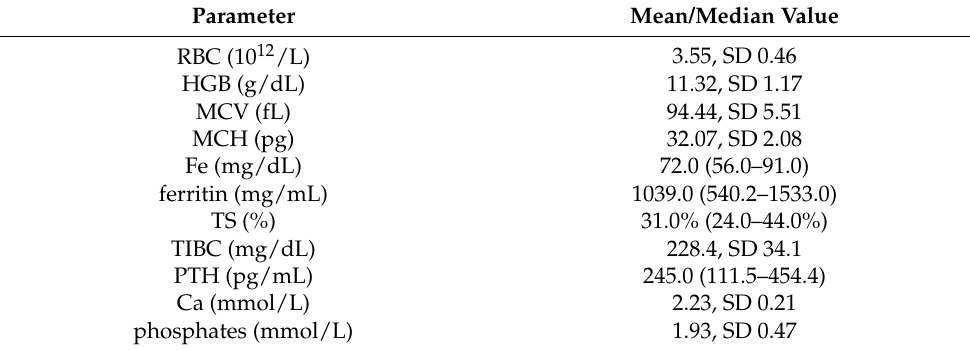
Table 7. Laboratory